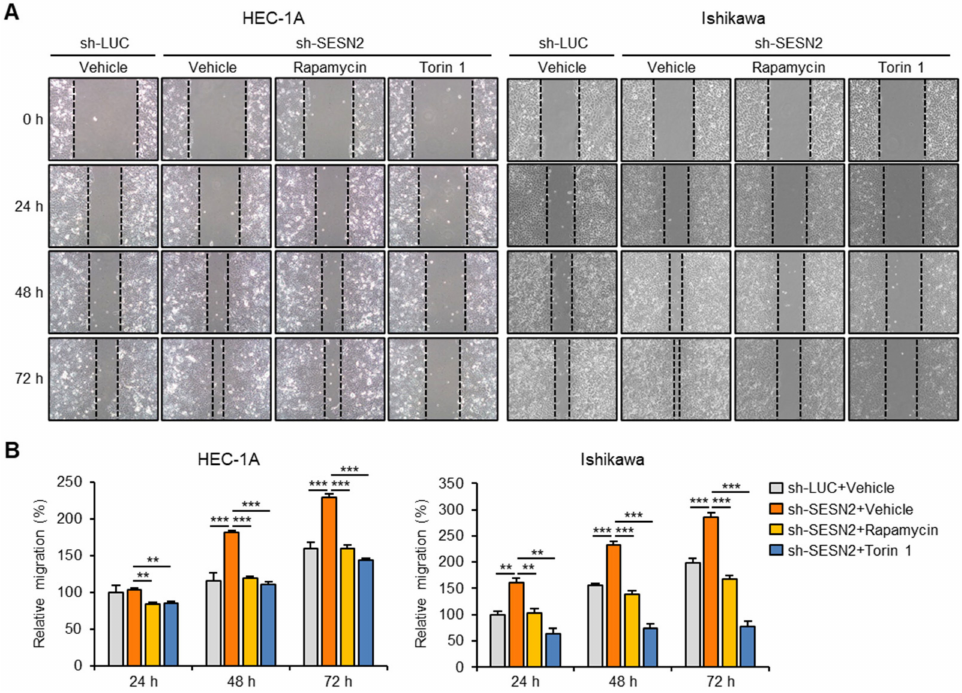
Figure 6. Knockdown of SESN2 increases migration of endometrial cancer cells in a mTOR-dependent manner. ( A ) Wound scratch assay in HEC-1A and Ishikawa cells infected with lentiviruses expressing shRNAs targeting luciferase (sh- LUC ) or SESN2 (sh- SESN2 ) and treated with 100 nM rapamycin or 250 nM Torin 1. Monolayers of cells were scratch-wounded with a sterile tip and photographed using a phase-contrast microscope at 0, 24, 48, and 72 h after wounding. ( B ) Quantification of wound migration in ( A ). Data are shown as mean ± SEM. Results are representative of at least three independent experiments. ** p < 0.01; *** p < 0.001 (Student’s t